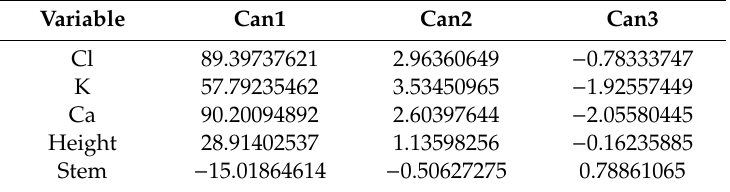
Table 6. Standardized canonical (Can) nutrient coe ffi cients, plant height, and rootstock stem